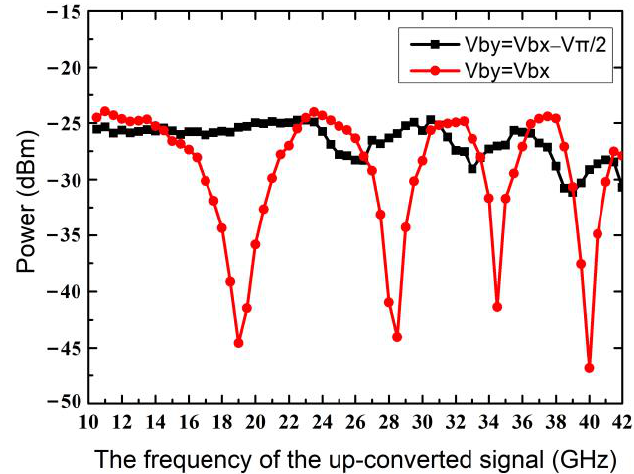
Figure 4. Frequency response of the microwave photonic mixer after 20 km SMF transmission, where the black squares and red circles are obtained under ϕ Y = ϕ X − π /2 and ϕ Y = ϕ X , respectively. The extinction ratios of the parent-MZM and the sub-MZMs in the DP-DPMZM were measured to be 22 dB and 20 dB, respectively. The maximum bias-voltage deviations of the four sub-MZMs in the DP-DPMZM were measured to be 7%, 4%, 14% and 4%, respectively. In addition, the frequency response of the PS and the 90 ◦ HC were measured by using a vector network analyzer (VNA, R&S, ZNA67, Munich, Germany), where the maximum phase deviation and amplitude imbalance are ± 6 ◦ and ± 0.4 dB for the PS, and ± 5 ◦ and ± 0.4 dB for the HC. Thereinto, the amplitude imbalance of ± 0.4 dB corresponds to a power imbalance ratio of 0.45 to 0.55. Figure 5a–f show the frequency response of the microwave photonic mixer obtained by carrying out numerical calculation with one parameter deviation under the worst cases and all other parameters holding at ideal levels, respectively. It can be seen from Figure 5 that, although the frequency-dependent power fading induced by independent parameter deviation is small, the combined effect together with the influence of the frequency response introduced by the DP-DPMZM, the PD and the cables is obvious, as depicted in Figure 4. Hence, it is critically important to select devices with large bandwidths and small parameter deviations to enhance the frequency-response flatness of the microwave photonic mixer with long-distance fiber transmission. In addition, the vestigial frequency-dependent power fading of Figure 4 is repeatable, and it can be compensated by increasing the power of the LO